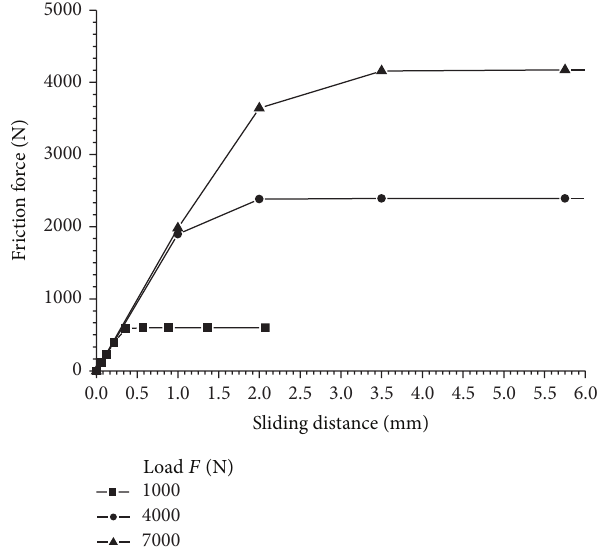
Figure 18: Friction force curves in X direction under different